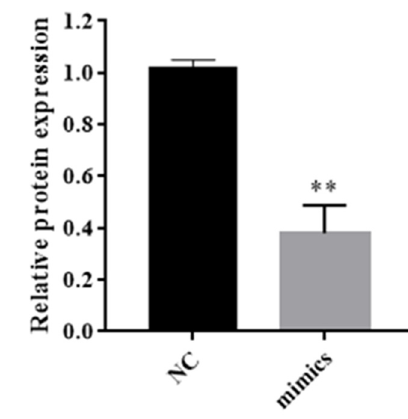
Figure 5. The overexpression of miR-F4-C12 repressed the protein expression of PIK3R1 in 3T3-L1 cells. Western blotting showed decreased protein expression of PIK3R1 in 3T3-L1 cells treated with miR-F4-C12 mimic compared to those treated with negative control miRNA (NC). Data are means ± SD. ** Indicates p < 0.01. Original western blot figures in Figures S2 and S3.